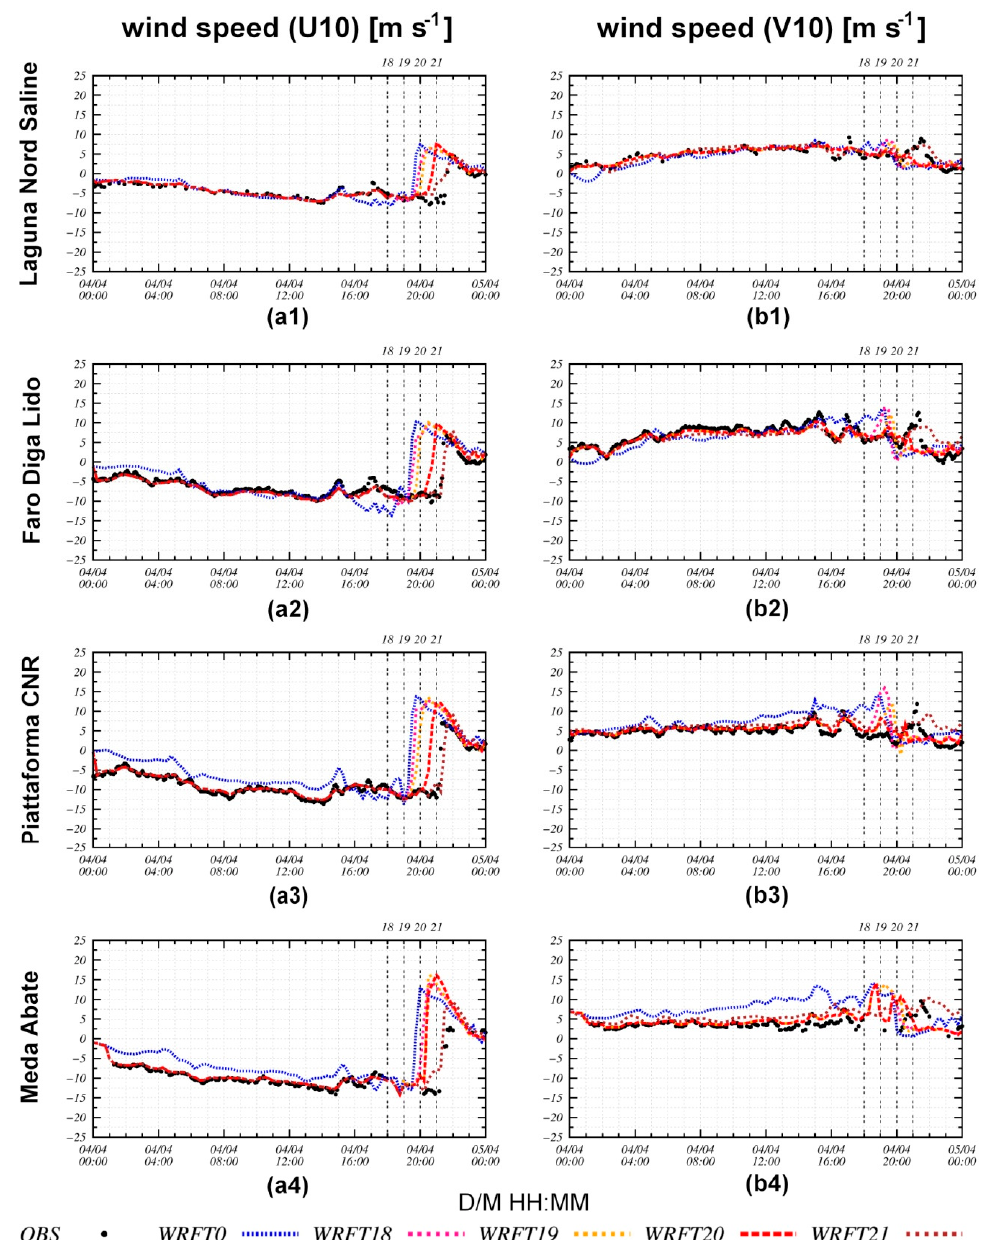
Figure 3. Zonal (left panels) and meridional (right panels) wind components (in m · s − 1 ) for a selection of weather stations (one for each row), sorted from north to south. Black dots represent the observed values. The blue line shows the values extracted from the inner grid (3 km) of the control run, while the pink, orange and red lines show values extracted from simulations with nudging until 18:00 UTC, 19:00 UTC, and 20:00 UTC,4April 2019,